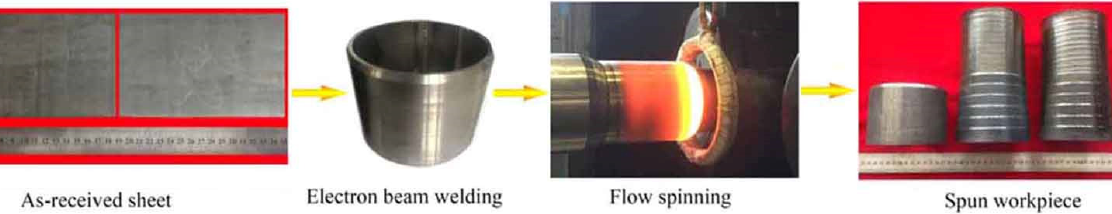
Figure 2. The apparatus of electromagnetic induction heating system for hot power spinning: ( a ) electromagnetic induction heating, ( b ) infrared temperature monitoring system, ( c ) and time- temperature curve during hot power spinning.